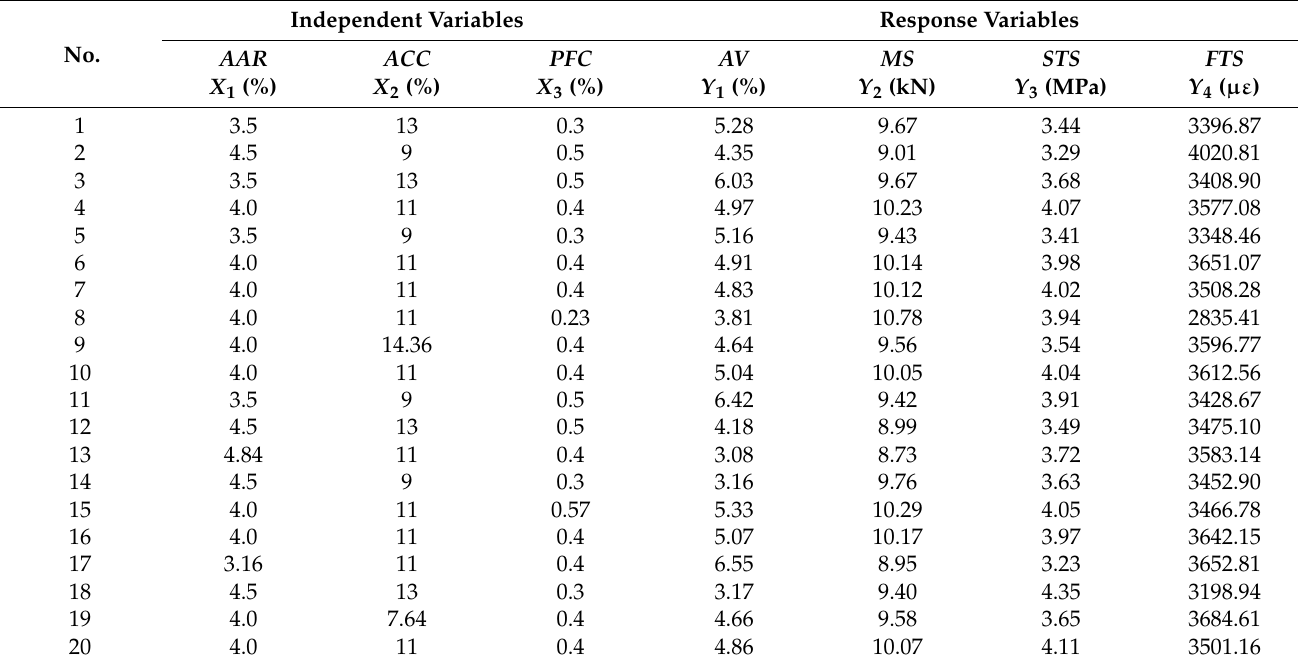
Table 7. Experimental design and results of